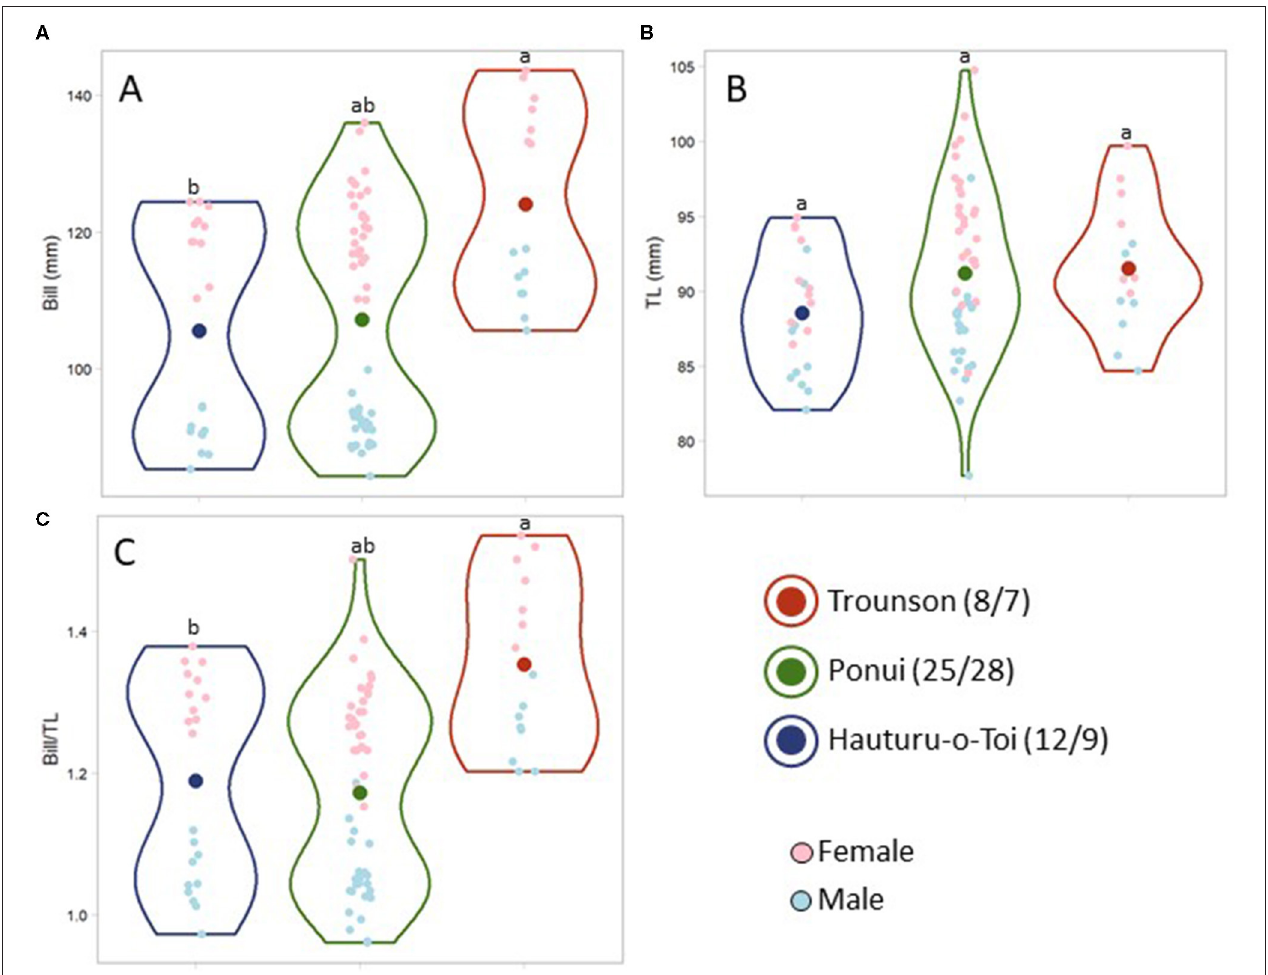
FIGURE 2 | Violin plots comparing morphometrics of adult A. mantelli from Hauturu-o-Toi, Ponui Island, and Trounson Kauri Park, specifically bill length (A) , tarsus length (B) , and the ratio between the two (C) . Different lowercase letters indicate significant difference. Small dots represent each data point and dot colour indicates the sex. Large dots represent the average size or ratio estimated for each population. The shape of the violin outline indicates the distribution of the data points. Sample size for males/females is indicated in the legend for each